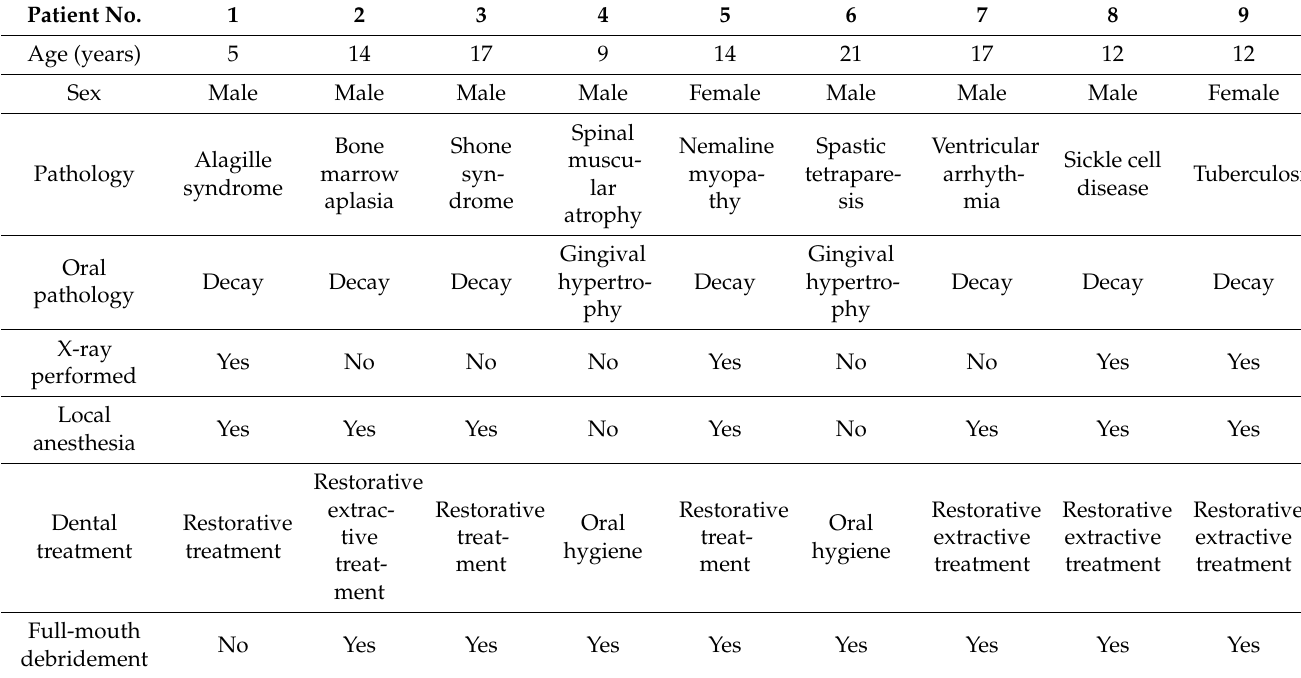
Table 1. Main clinical data, dental pathology, and dental treatment performed at beside in nine SNPs. Patient